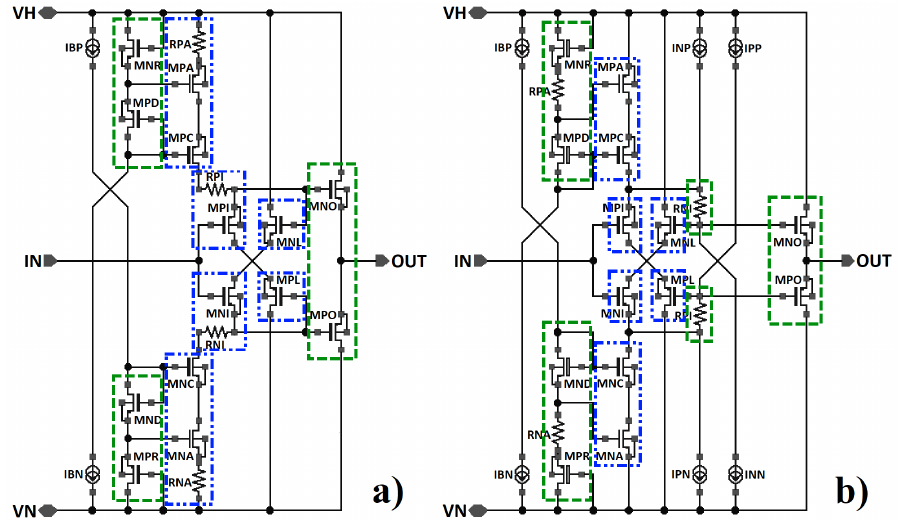
Figure 2. Two versions of the buffer equipped with sets of small resistors: ( a ) for higher gate source voltages of medium/high-voltage MOS transistors; ( b ) for the opposite case [1].